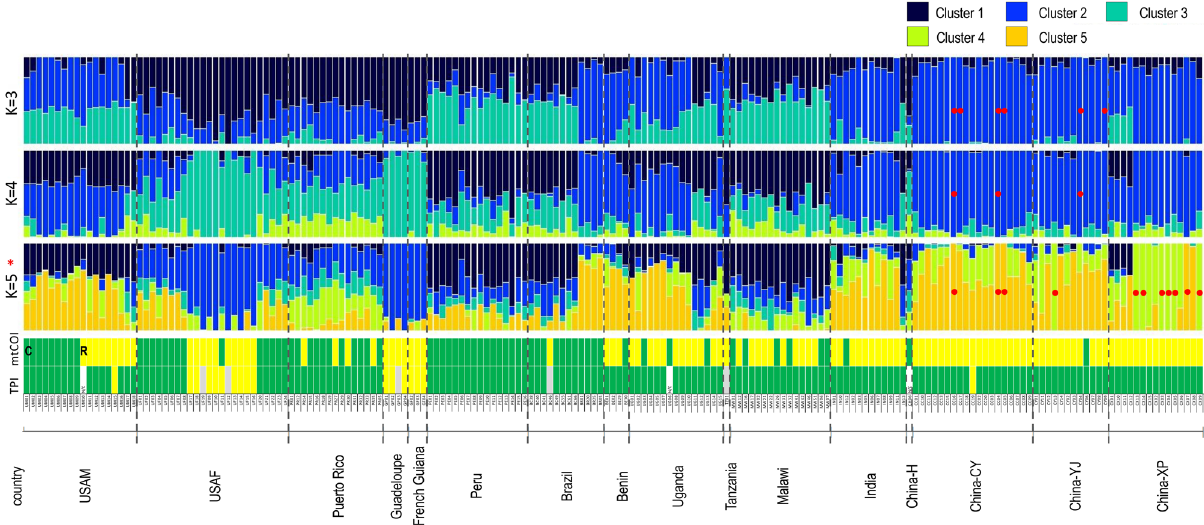
Fig. 5 Admixture analysis of invasive and native Spodoptera frugiperda populations based on 870 neutral SNP loci, and individual host strain identity based on the Tpi and the mt COI markers. Admixture analysis based on K = 3 (Cross-Validation Error (CVE): 0.375), K = 4 (CVE: 0.377), and K = 5 (CVE: 0.380)). Populations ‘ USAM ’ and ‘ USAF ’ are from Mississippi and Florida, respectively. Populations from China were from Cangyuan (CY), Yuanjiang (YJ), Xinping (XP) in Yunnan Province. Individuals in the invasive ranges that lacked the signature of admixture are indicated by red dots. Corn- ( ‘ C ’ ) or rice- ( ‘ R ’ ) preferred plant hosts are identi fi ed based on mtCOI as per Dumas et al. 41 , and by Tpi SNP approach as per Nagoshi 48 are indicated by green or yellow bars, respectively. Specimen ID ’ s and sampling countries are as labelled. ‘ N/C ’ for Tpi indicates no coverage. Grey bars indicate individuals with heterozygous Tpi